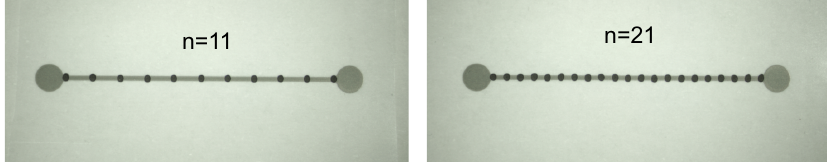
Figure 10. Strain sensors with eleven (n = 11) and twenty one (n = 21) sensing elements.